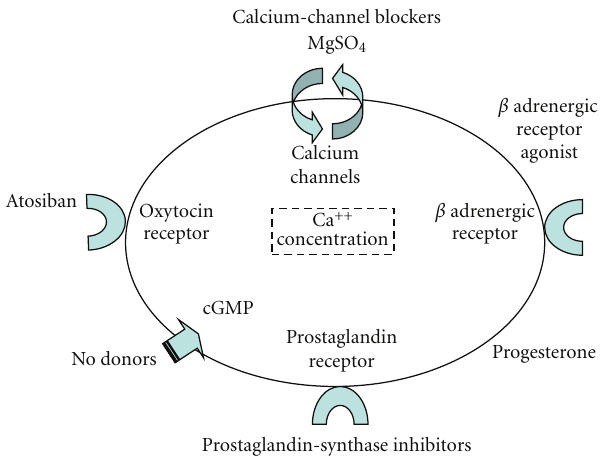
Figure 1: Mechanisms of action for